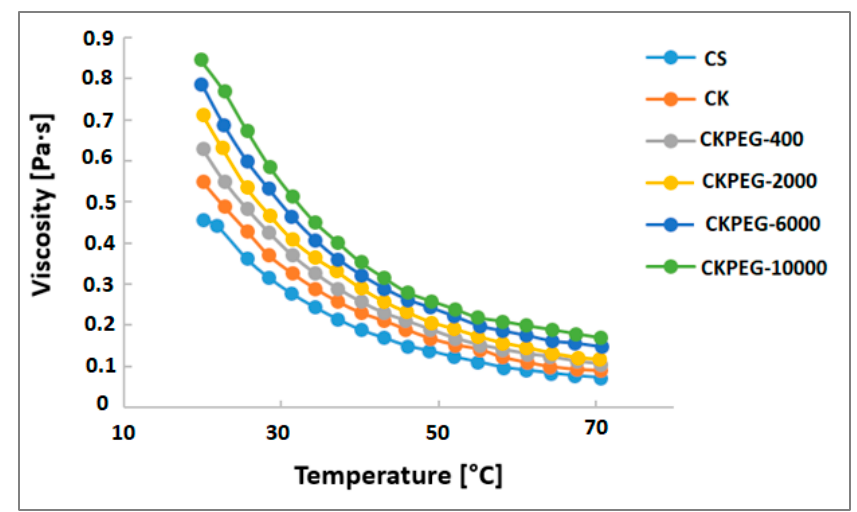
Figure 1. Evolution of the viscosity with temperature for the di ff erent prepared dope solutions.